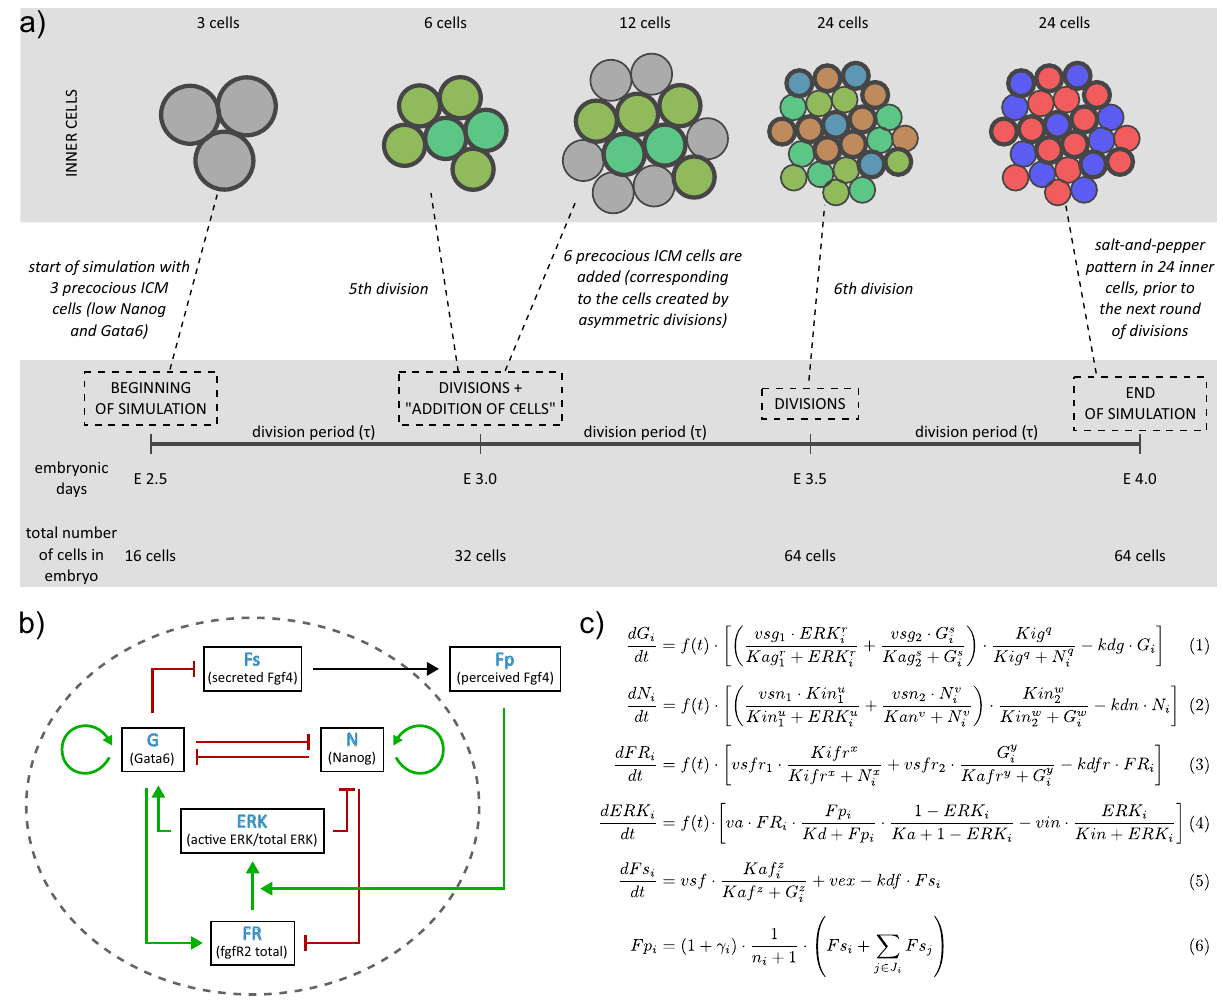
Fig. 1 a Scheme of the model of development of epiblast ( Epi ) and primitive endoderm ( PrE ) lineage from inner cells ( ICM ). The model does not consider trophectoderm explicitly and starts from three inner cells originating from the fi rst round of differentiative divisions ( In1 ). The three cells begin the process of speci fi cation to Epi and PrE cells. In the second round of divisions, the three In1 cells divide into six cells, whereas differentiative divisions add six ICM cells ( In2 ). Thus, at E3.0 the inner part of the embryo consists of six In1 and six In2 cells. The development of Epi and PrE lineage and the emergence of the salt-and-pepper pattern continues until E4.0. The colour code is: grey for blastomers in which Nanog and Gata6 are low, green for ICM cells, red for Epi cells and blue for PrE cells. b Gene regulatory network ( GRN ) present in each of the modelled cells. c Equations of the GRN model, describing the rate of change of concentrations of Gata6 ( G ), Nanog ( N ), FgfR2 ( FR ), secreted Fgf4 ( Fs ) and perceived Fgf4 ( Fp ) as well as the level of activity of the Erk pathway (ERK) . Index i denotes the i th cell and n i the number of neighbouring cells. See text for details. De fi nitions and values of parameters used in simulations can be found in Supplementary Tables S1 –